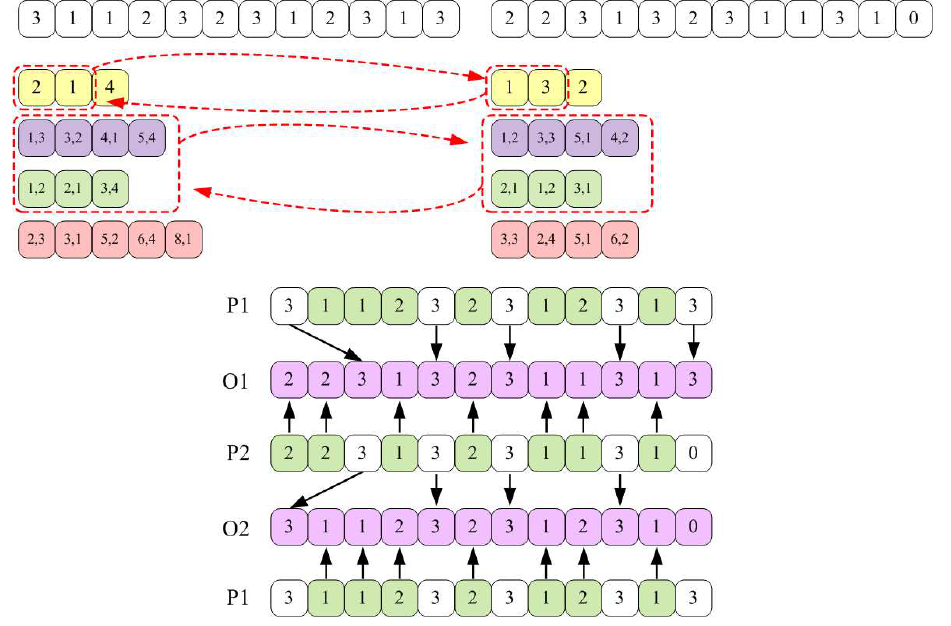
Figure 5. The crossover